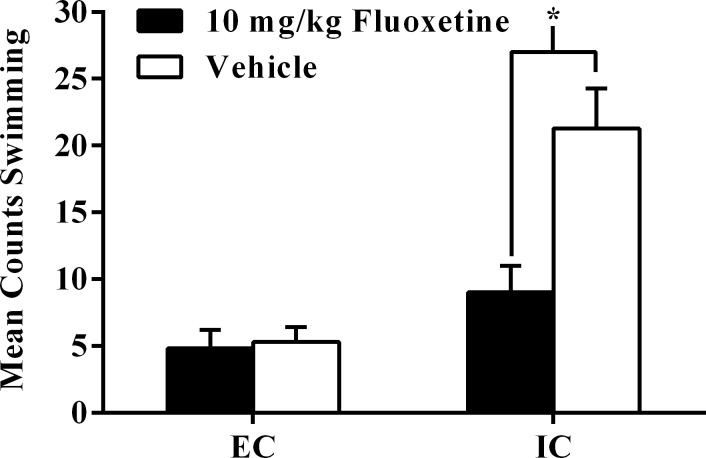
Experiment I Forced Swim Test Swimming.Experiment I total mean counts (±SEM) of swimming behavior between EC and IC rats after subchronic fluoxetine (10 mg/kg, i.p.) or vehicle administrations 23.5 hrs, 5 hrs, and 1 hr before the FST. Asterisk (*) indicates IC rats receiving vehicle exhibited significantly more swimming than IC rats receiving fluoxetine injections (p < .05).